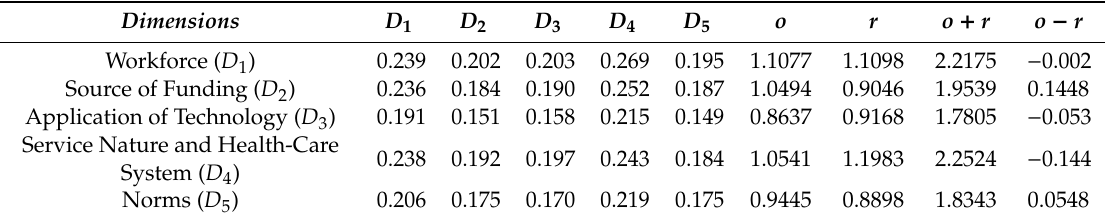
Table A4. The total influence matrix of criteria T D and sum of influences given / received on dimensions.